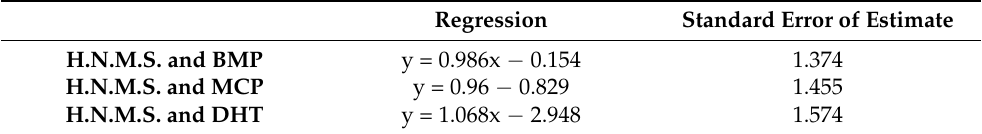
Table 2. Regression lines and standard errors of estimation between H.N.M.S data and each sensor.